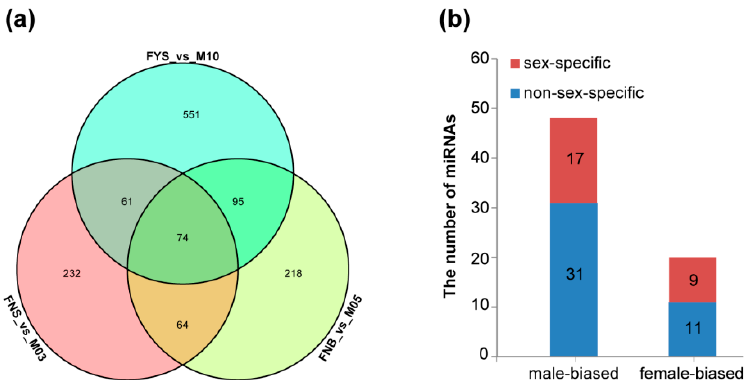
Figure 2. Differentially expressed miRNAs. ( a ) the Venn diagram of DE miRNAs among three flower stages; ( b ) the number of sex-biased expression miRNAs.